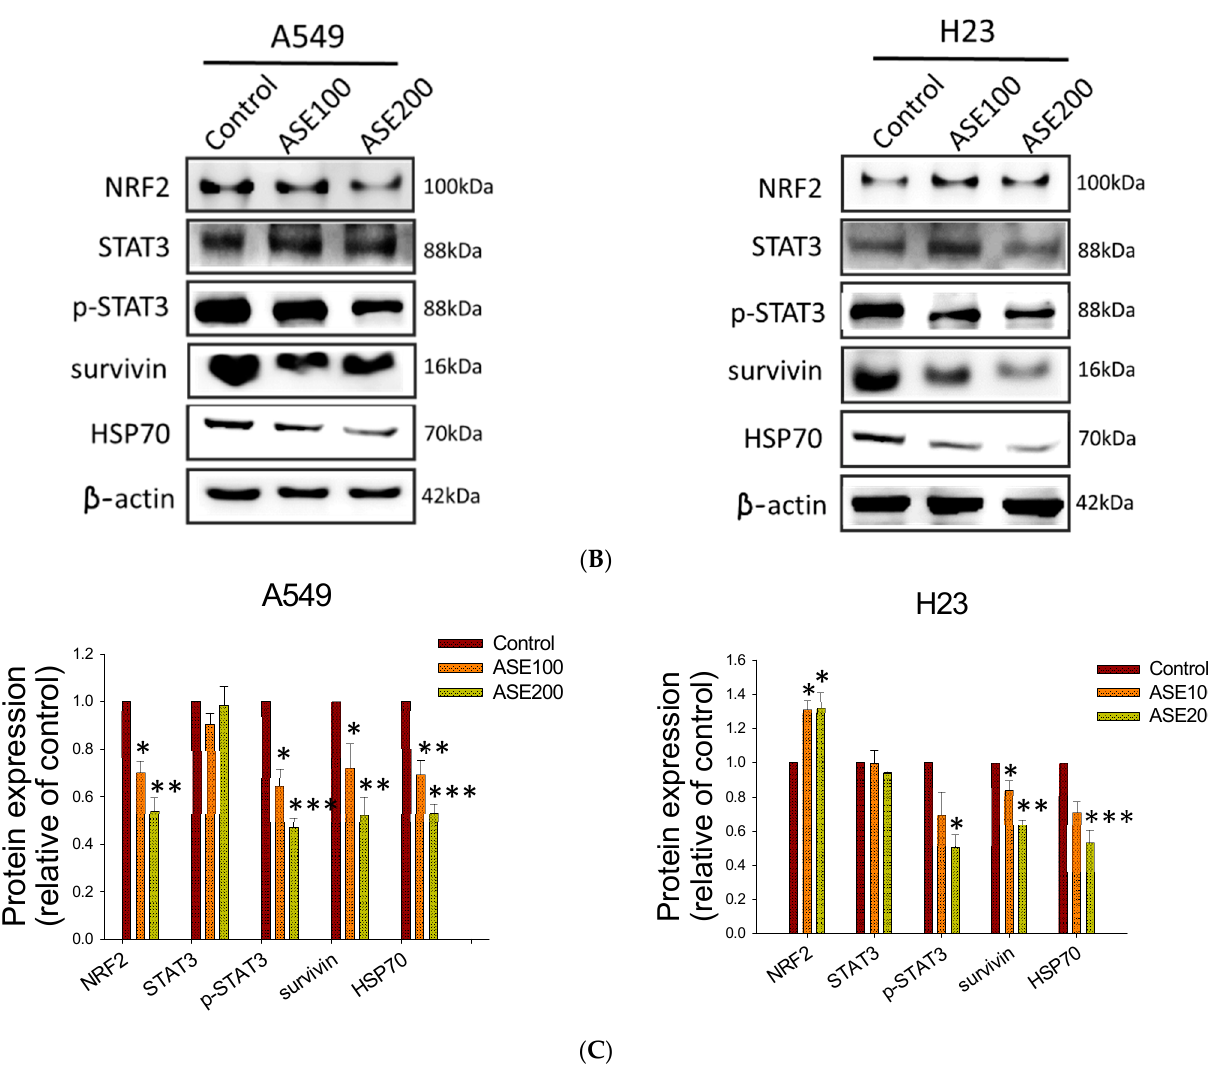
Figure 4. Effects of the ethanol extract of Artemisia santolinifolia (ASE) on the nuclear factor erythroid- 2-related factor 2 (NRF2)/signal transduction and activator of transcription 3 (STAT3) axis and on downstream prosurvival proteins. ( A ) Flow diagram of the ASE-targeted interaction network. ( B ) A549 and H23 cells were treated with the ASE at concentrations of 100 and 200 μ g/mL for 48 h. Expression levels of NRF2, STAT3, phosphorylated (p)-STAT3, survivin, and heat shock protein 70 (HSP70) were detected by Western blotting. β -actin was used as a loading control. ( C ) Histograms quantifying of three replicates of Western blot results. Data are the mean ± SE; * p < 0.05, ** p < 0.01, *** p < 0.001 vs. the corresponding control.